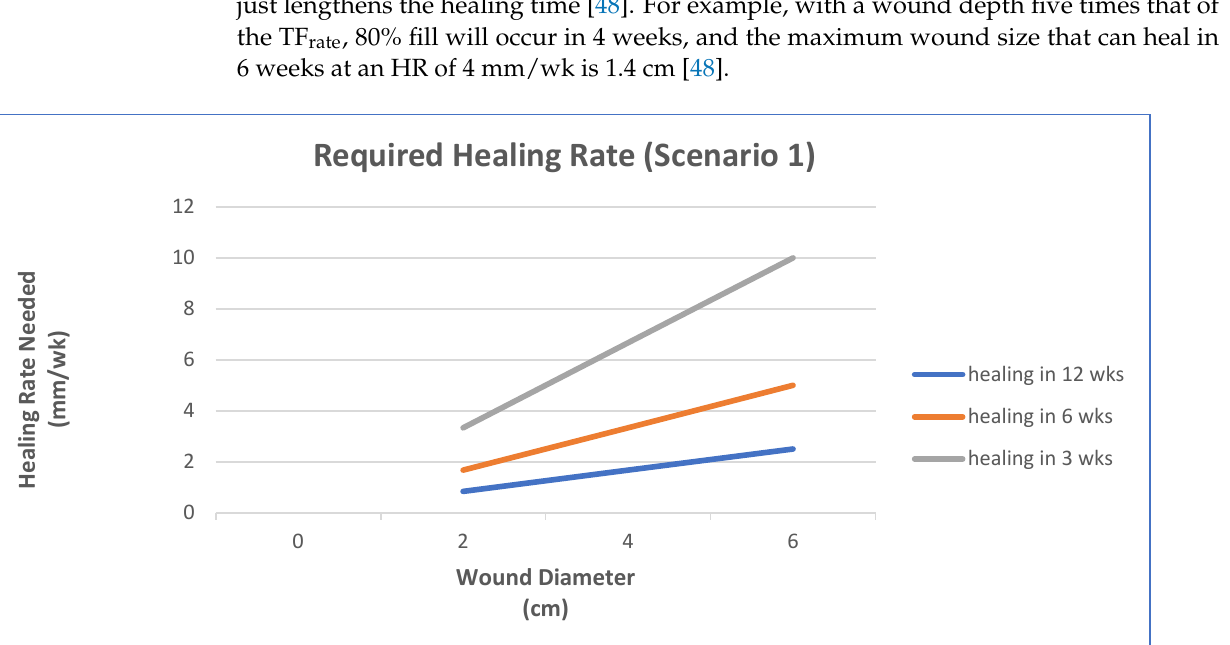
Figure 3. Graph representing the tissue fill rate needed if healing is to occur within the specified time for the given wound diameter. This represents scenario 2.